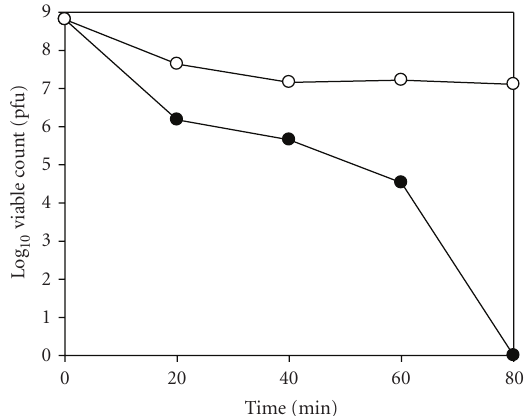
Figure 11: Killing of Bacteriophage T4 on Ag over TiO 2 • with control sample ◦